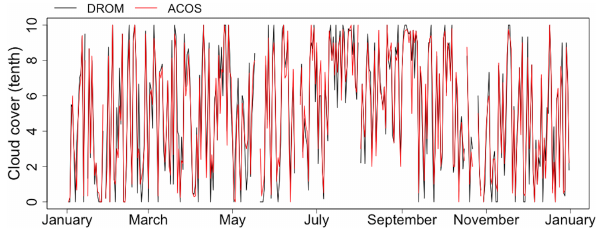
Figure 7. Daily mean time series of observed (DROM) and calcu- lated (ACOS) cloud cover for the test